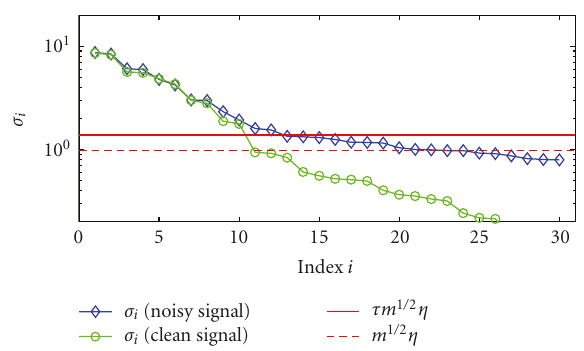
Figure 3: The singular values of the Hankel matrices H (clean sig- nal) and H (noisy signal). The solid horizontal line is the “safe- √ 2 m 1 / 2 η ; the numerical rank with respect to guarded” threshold this threshold is k =